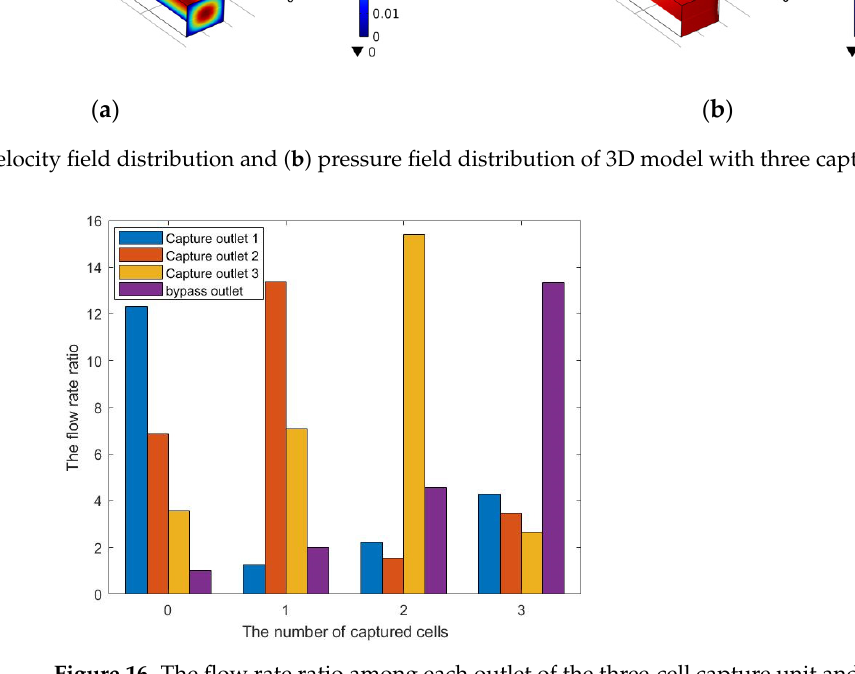
Figure 16. The flow rate ratio among each outlet of the three-cell capture unit and the bypass outlet under different numbers of captured cells.